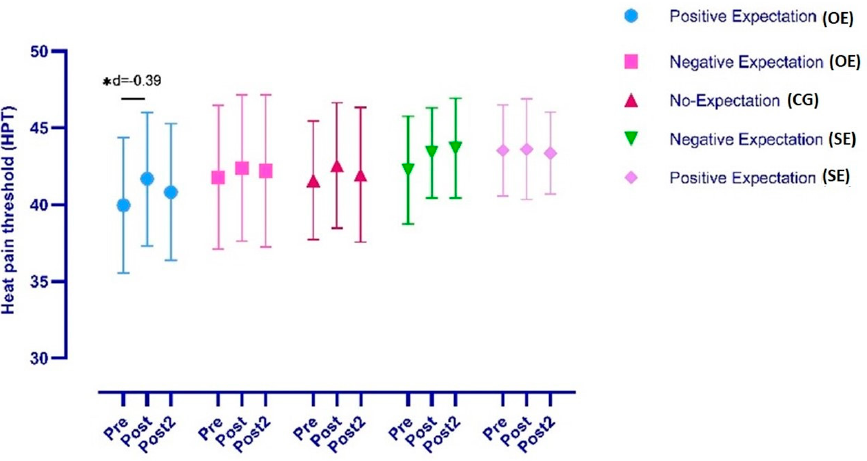
Figure 2. Differences in heat pain threshold between groups and time–group interaction, * p < 0.05.